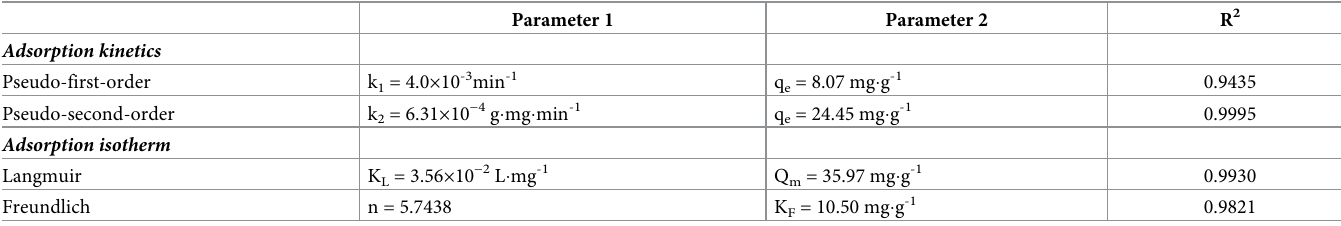
Table 3. Parameters of kinetic and isotherm models for Ni adsorption onto